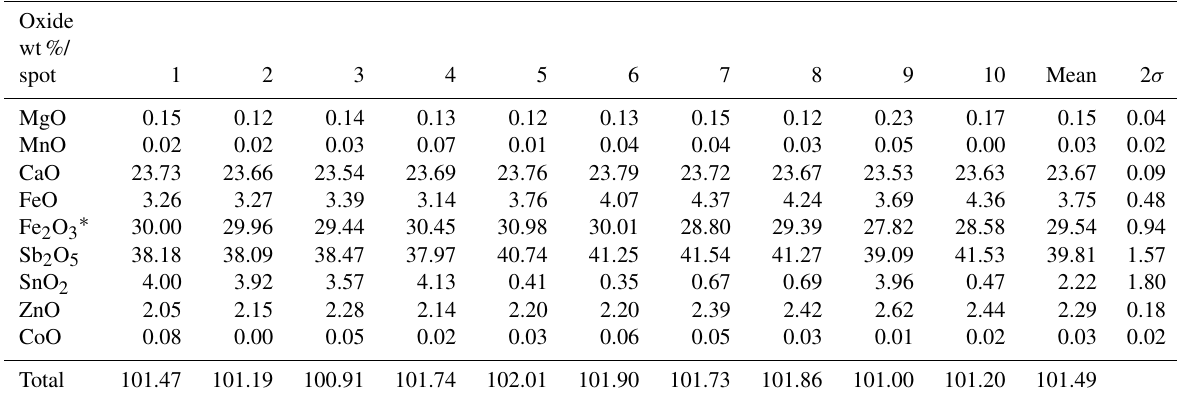
Table 2. Chemical composition (wt%) of monteneveite from EPMA analyses. Oxide wt%/ spot